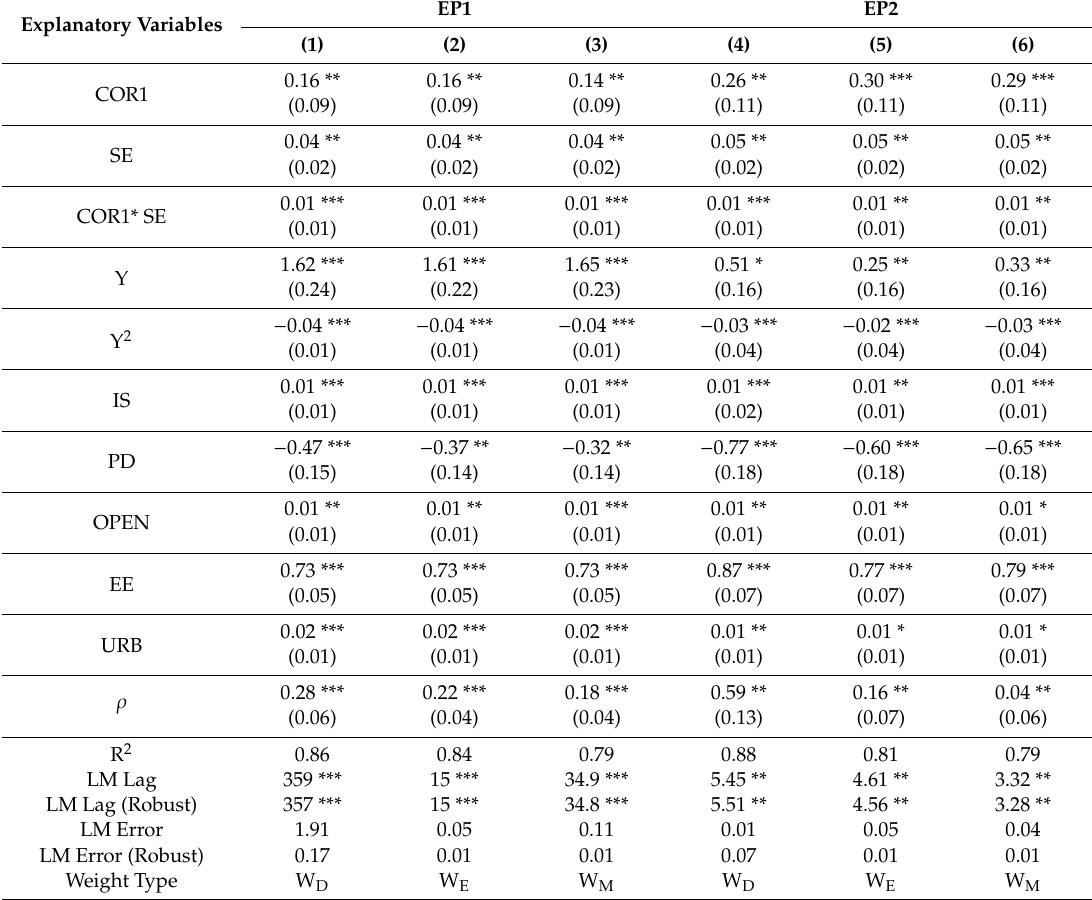
Table 3. Influence of corruption and hidden economy on environmental